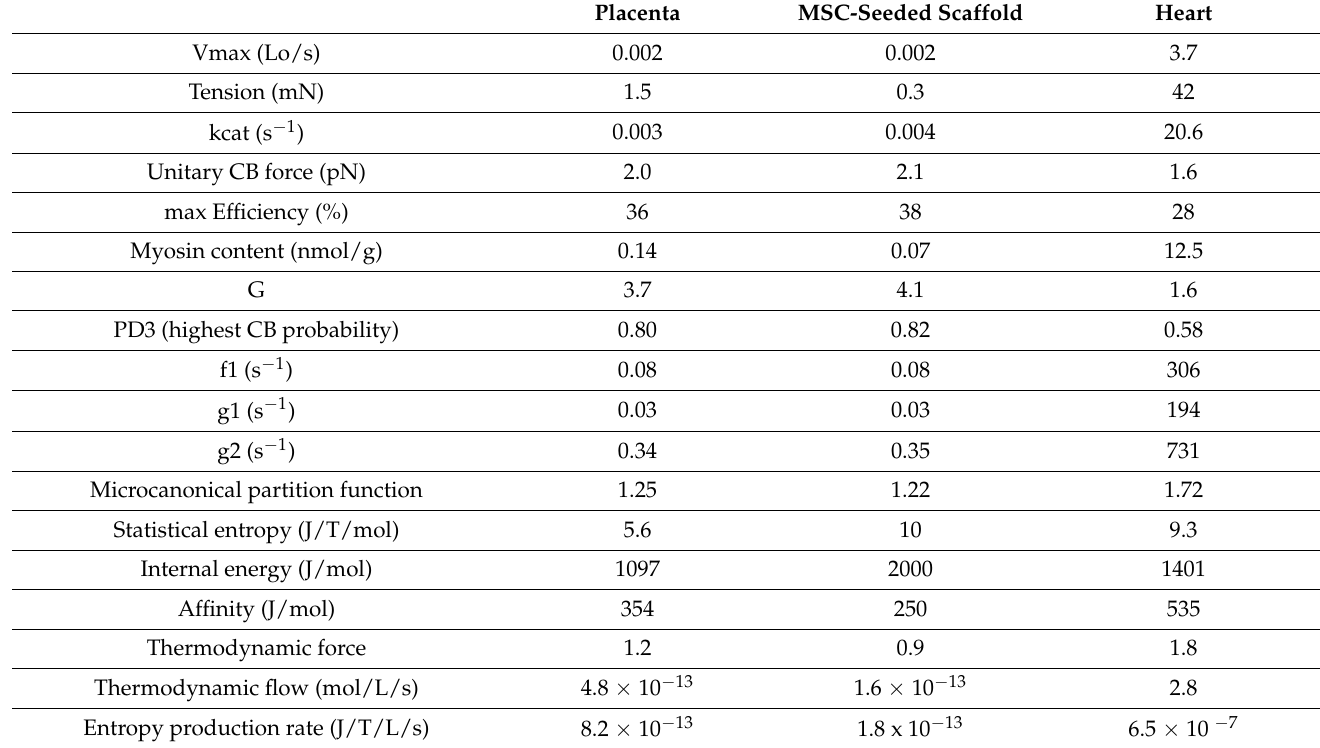
Table 1. Mechanical and thermodynamic properties of human placental stem villi, MSC-seeded in collagen scaffold, and heart muscle. Main mechanical parameters, molecular myosin characteristics, and thermodynamic quantities in human placental stem villi, MSCs seeded in collagen scaffold, and heart muscle. Only mean values are represented without SD. Placenta MSC-Seeded Scaffold Heart 0.002 0.002 3.7